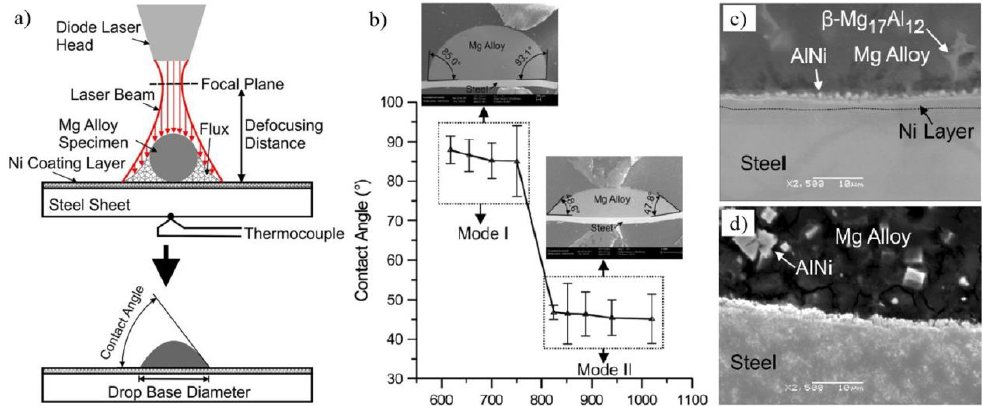
Figure 12. ( a ) Schematic representation of the wetting test; ( b ) the contact angle as a function of the peak temperature during wetting experiments; ( c , d ) the SEM micrographs of the Mg alloy-steel interface of the wetting sample at peak temperatures of 928 K and 1097 K [51].